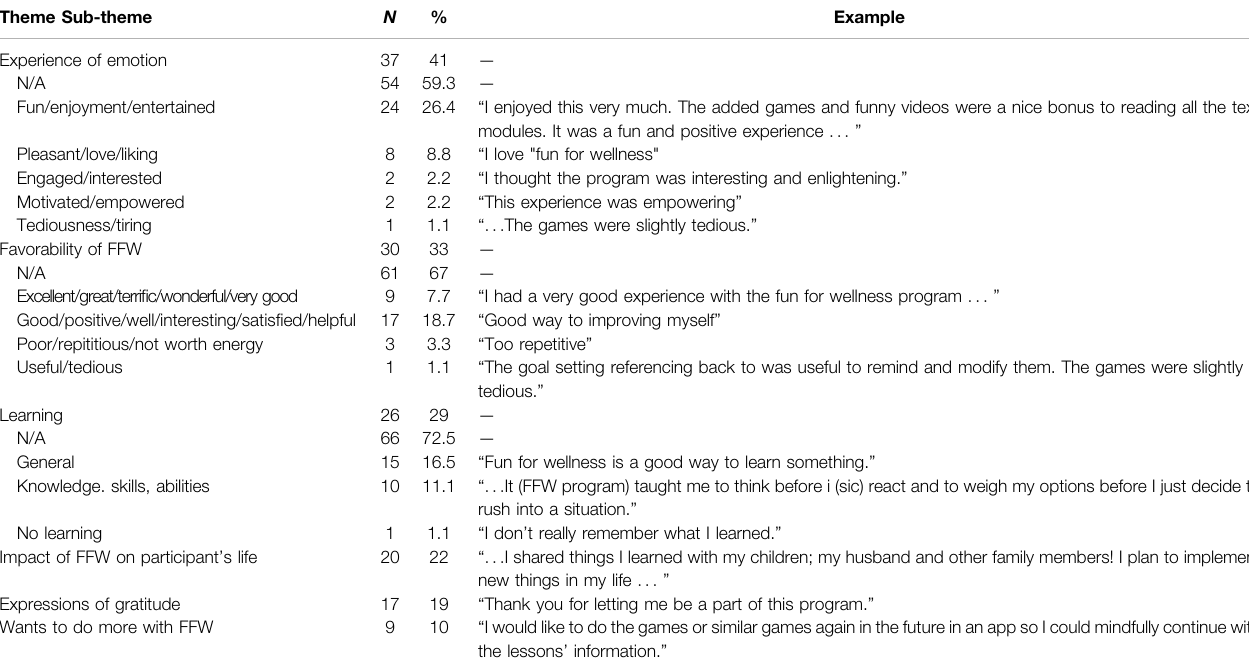
TABLE 2 | Qualitative responses by